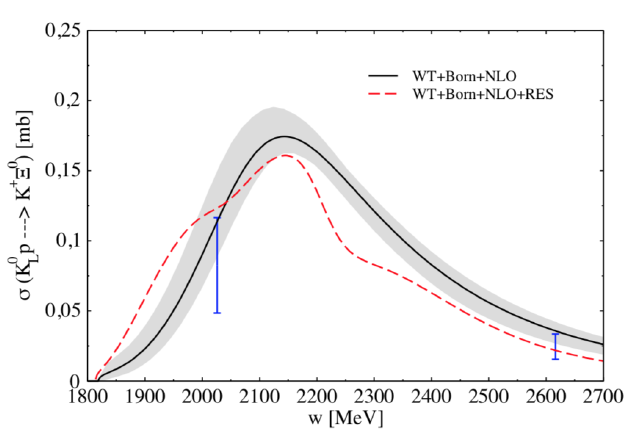
Figure 2. Total cross sections of the K 0 p → K + Ξ 0 reactions for both models. The experimental points L of the I = 1 K − n → K 0 Ξ − reaction, taken from [17, 18] and divided by